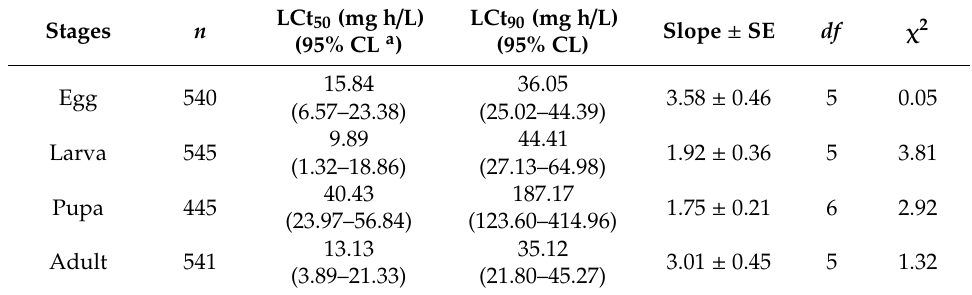
Table 3. Lethal concentration time of L. serricorne exposed to EF fumigant mixed with PH 3 (0.5 mg /